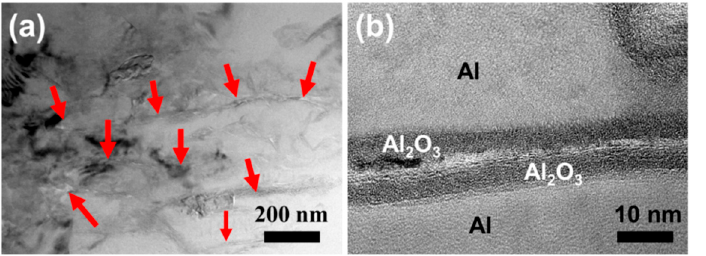
Figure 10. ( a ) TEM images of the interface structure in 1.5 wt.% FLM/Al composite at 550 °C, ( b ) HRTEM image of a FLM/Al interface.